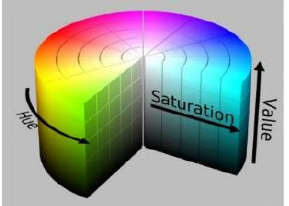
Figure 4. Image in the HSV color space.